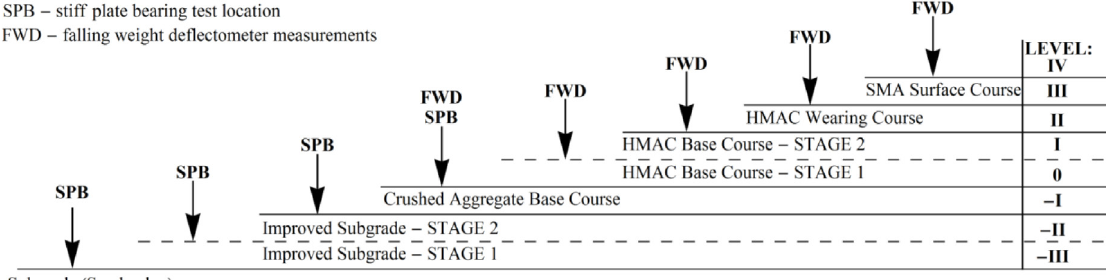
Fig. 4. Analysed pavement structure with marked test points (SPB tests and FWD measurements)